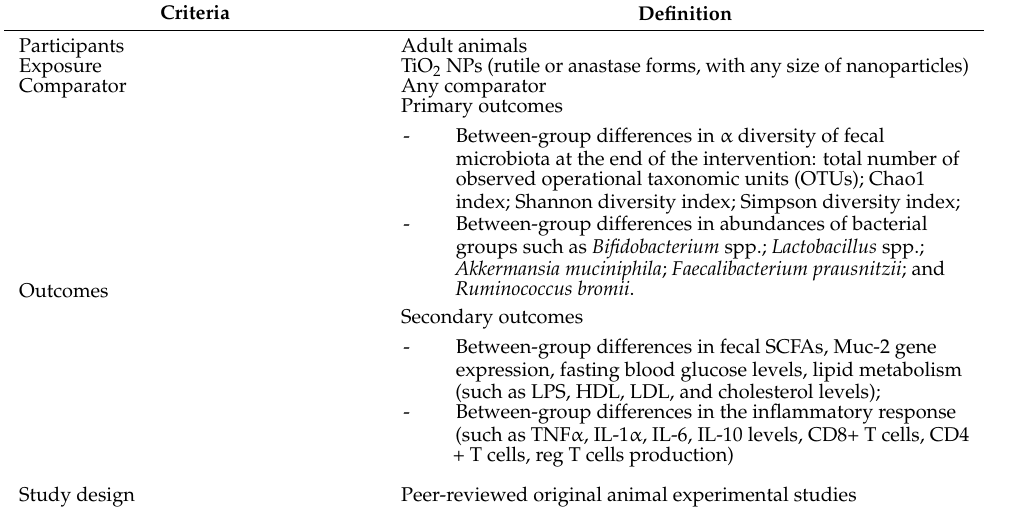
Table 1. PICOS criteria for inclusion of studies.